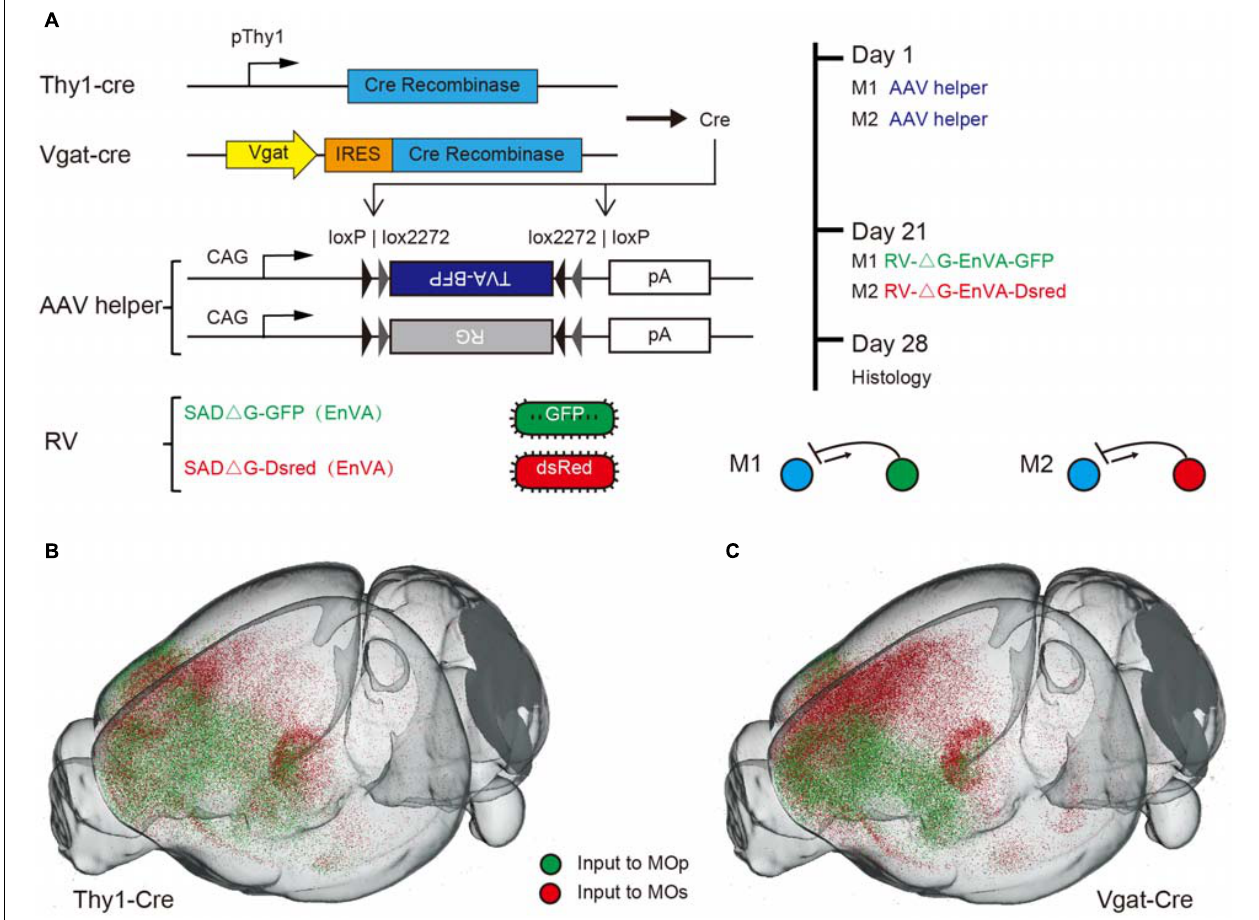
FIGURE 1 | Monosynaptic rabies tracing the inputs to specific neurons in MC. (A) Schematic showing the dual-color monosynaptic rabies tracing technique with cre dependent mice (Thy1-cre mice and Vgat-cre mice) and viral vectors. (B,C) 3D reconstruction of the whole brain dataset acquired using the fMOST system. Green dots denote neurons projecting to the MOp while red dots denote neurons projecting to the